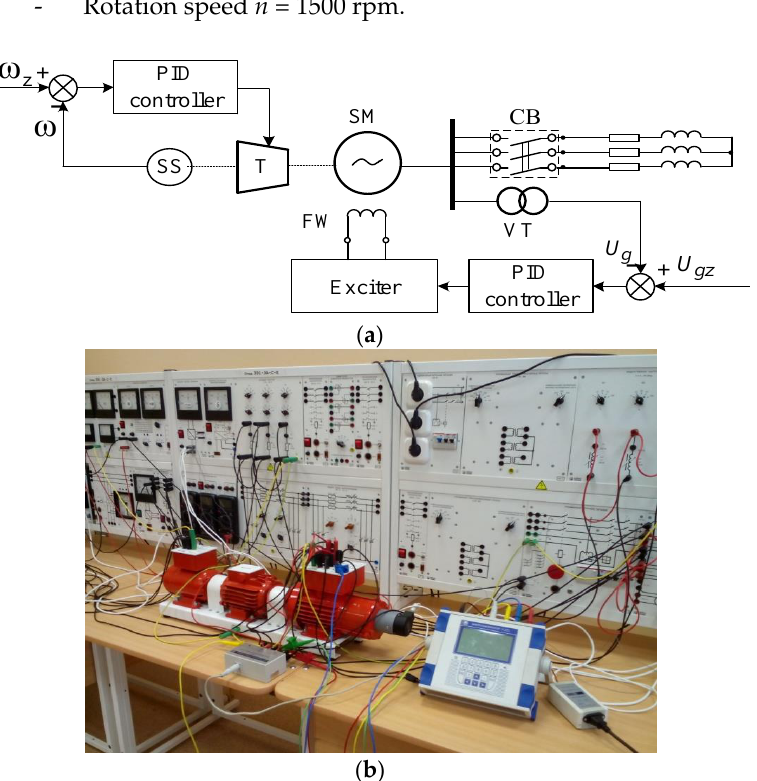
Figure 5. Schematic ( a ) and photo ( b ) of the experimental setup: SS—RPM sensor; T—turbine; SM—synchronous machine; FW—field winding; VT—voltage transformer; CB—circuit